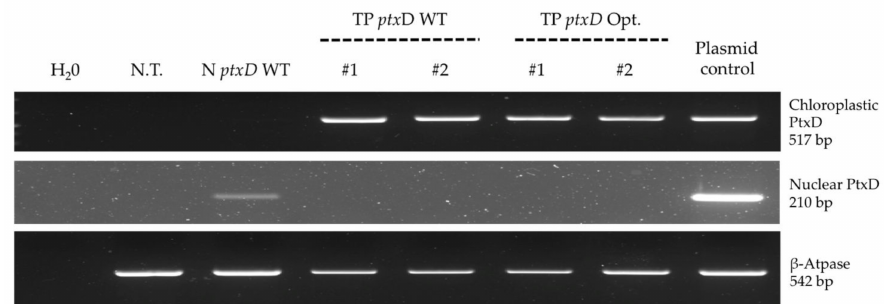
Figure 3. PCR-based genetic characterization of selected transformant lines. Three independent reactions were set up to reveal the presence of the ptxD transgene sequence(s). The upper panel refers to the amplification of the chloroplast codon usage-optimized ptxD sequence, while the middle panel refers to the amplification of the nucleus codon usage-optimized ptxD version. A control reaction (lower panel) was set-up to verify the quality of extracted genomic DNA targeting the ATP-ase β subunit gene. Additional control reactions were performed with appropriate primer pairs on vectors containing the ptxD sequences introduced in the algae (IR-int and pChlamy-4 for the chloroplast and nuclear version respectively).